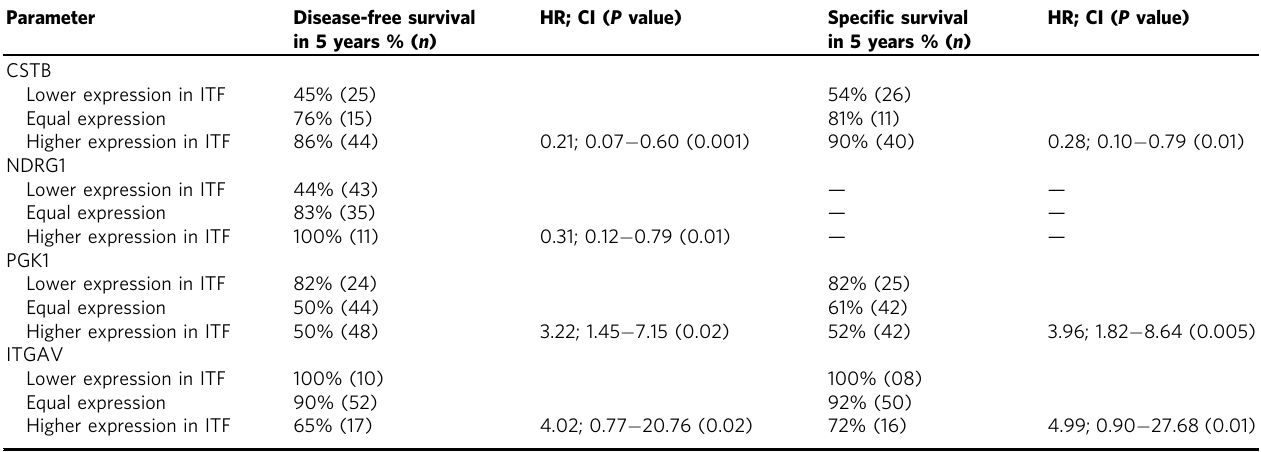
Table 2 Kaplan − Meier survival analysis of OSCC patients according to the levels of protein expression obtained by IHC analysis